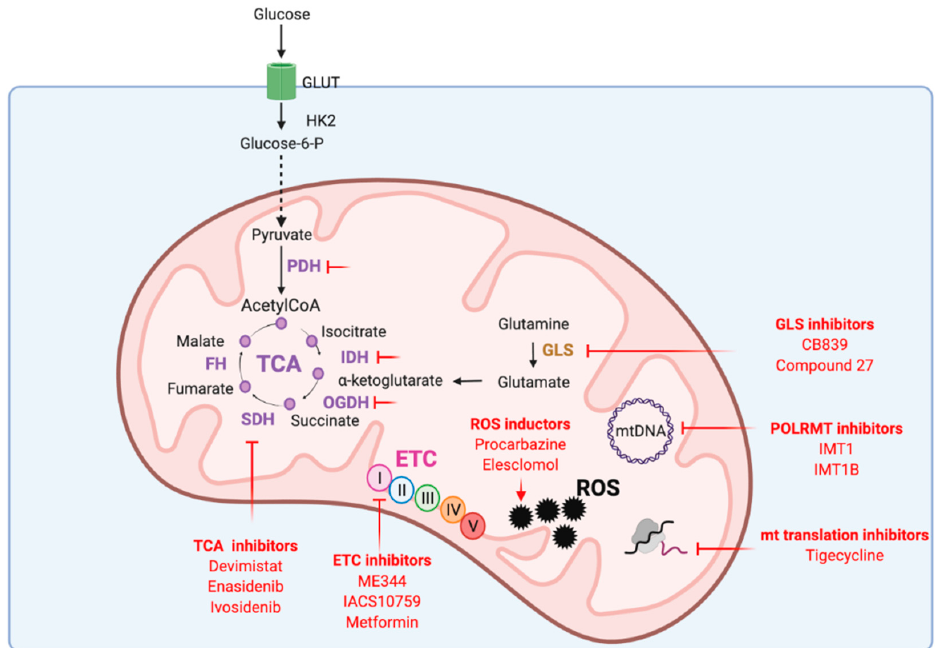
Figure 3. Mitochondrial functions targeted in cancer therapy. ETC: electron transport chain, FH: fumarate hydratase, GLS: glutaminase, GLUT: glucose transporter, HK2: hexokinase 2, IDH: isocitrate dehydrogenase, mtDNA: mitochondrial DNA, OGDH: α -ketoglutarate dehydrogenase, PDH: pyruvate dehydrogenase, POLRMT: mitochondrial RNA polymerase, ROS: reactive oxygen species, SDH: succinate dehydrogenase, TCA: tricarboxylic acid cycle.